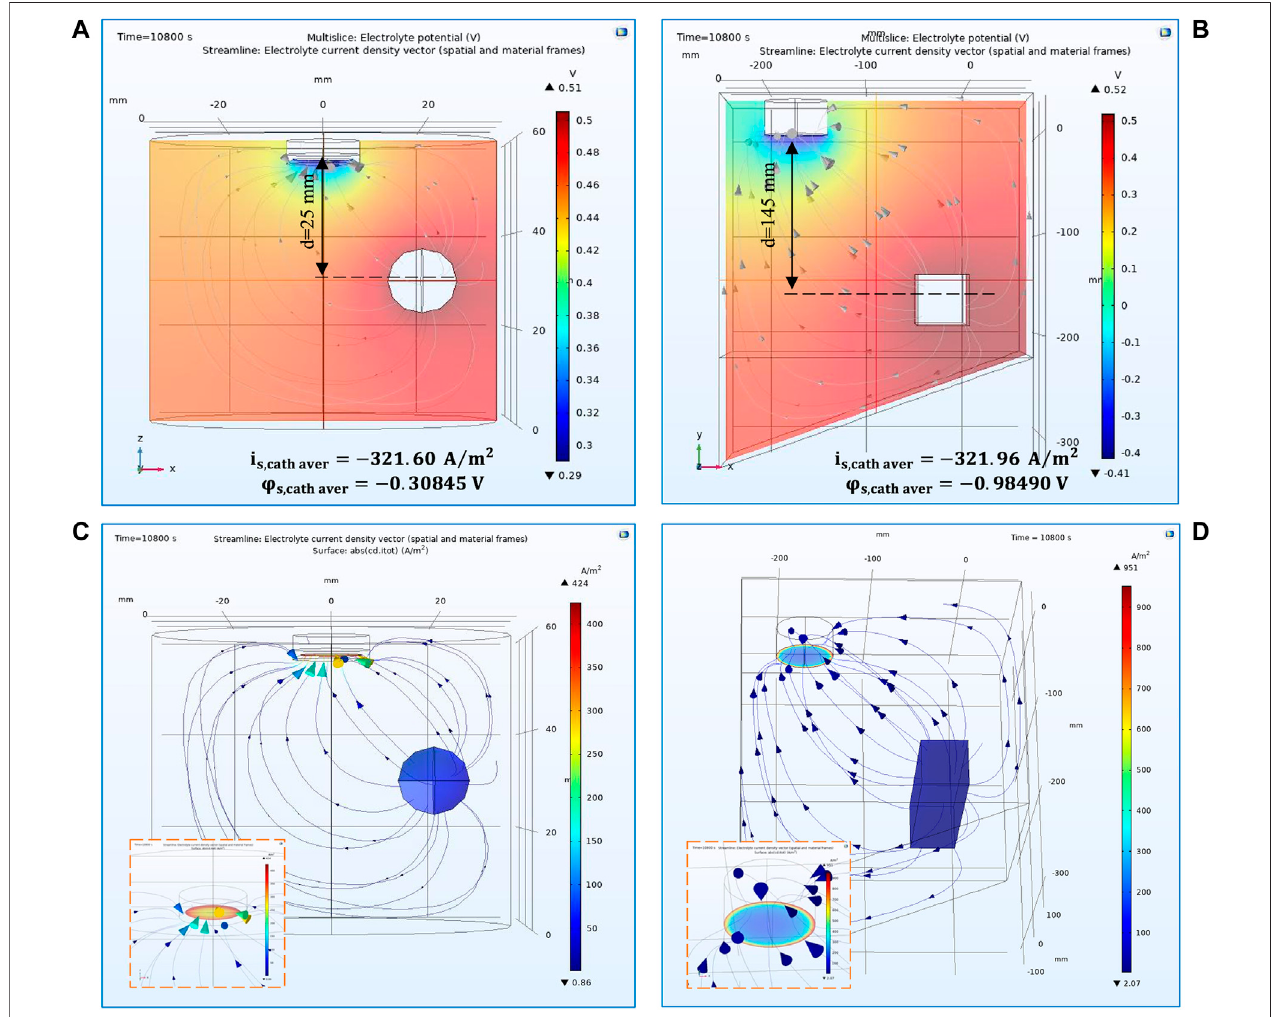
FIGURE 3 | 3-D representation of potential distribution in the electrolyte volume of (A) the RDE and (B) the electroforming reactor. 3-D representation of current distribution on the cathode surface for (C) the RDE and (D) the electroforming reactor. The results simulate potential and current distributions after 3 h at 50 ℃ . The currentstreamlinesinbothelectrolyticvolumesarealsoshownin fi gures (C,D) emanatingfromtheanode(athigherpotential)andbeingcollectedatthecathode(atlower potential).Theverticaldistancebetweentheelectrodes ’ sgeometricalcentresisalsonotedin fi gures (A,B) .Currentdistributiononthecathodes ’ surfaceisshownin the cathode surface close ups provided in fi gures (C,D)